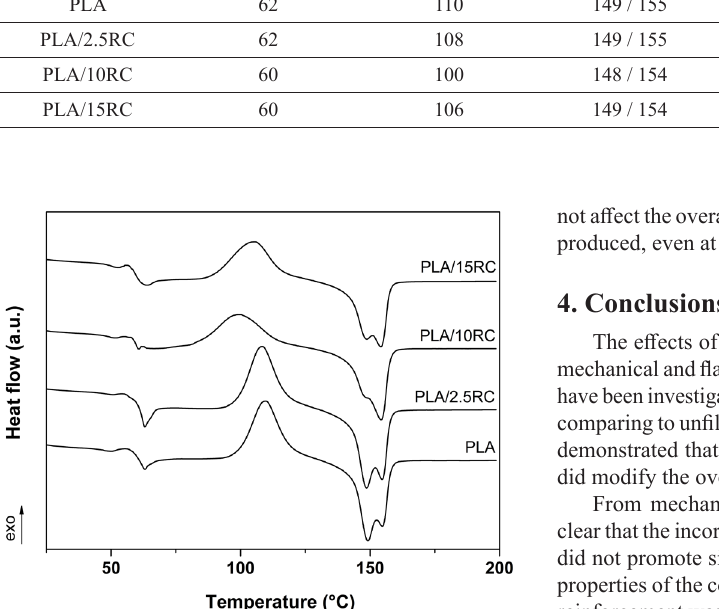
Table 4. Thermal parameters of the injection molded samples obtained by DSC (first heating cycle). Sample